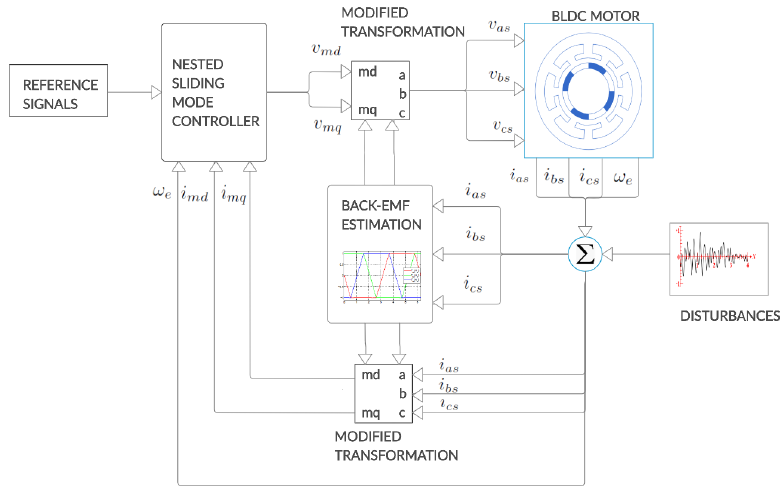
Figure 4. Block Diagram of the developed